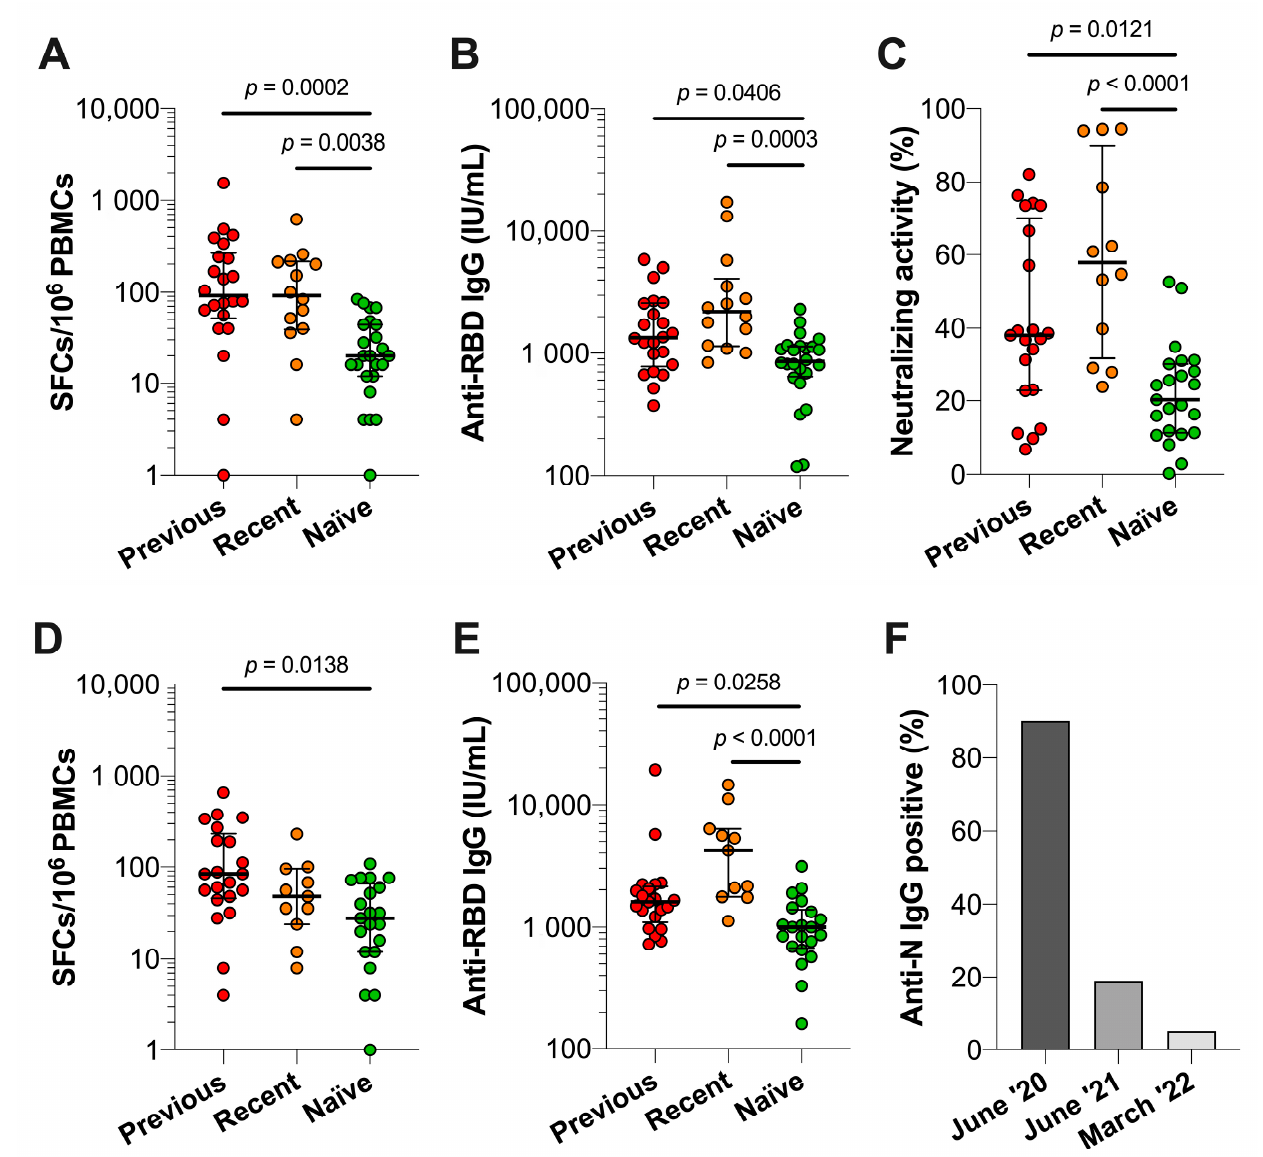
Figure 5. SARS-CoV-2-specific T cell and antibody responses of previously infected, recently infected, and infection-naïve HCWs. Immune responses were assessed at t2 (median 126 (IQR 122–131) days after receiving BNT162b2 or mRNA-1273 booster vaccination) and t3 (median 209 (IQR 204–212) days after receiving BNT162b2 or mRNA-1273 booster vaccination). ( A ) SARS-CoV-2 S1-specific T cell responses at t2 of previously infected ( n = 22), recently infected ( n = 14), and infection-naïve HCWs ( n = 24). ( B ) Anti-RBD serum IgG concentrations at t2 of previously infected ( n = 22), recently infected ( n = 14), and infection-naïve HCWs ( n = 24). ( C ) Neutralizing activity against SARS-CoV-2 RBD at t2 of previously infected ( n = 21), recently infected ( n = 12), and infection-naïve HCWs ( n = 23). ( D ) T cell responses against SARS-CoV-2 S1 and N at t3 between previously infected ( n = 21), recently infected ( n = 11), and infection-naïve HCWs ( n = 21). ( E ) Anti-RBD serum IgG concentrations at t3 between previously infected ( n = 21), recently infected ( n = 11), and infection-naïve HCWs ( n = 21). Indicated is the median with IQR and statistical significance was assessed with a Kruskal–Wallis test with Dunn’s multiple comparison test. ( F ) Percentages of serum anti-N IgG-positive